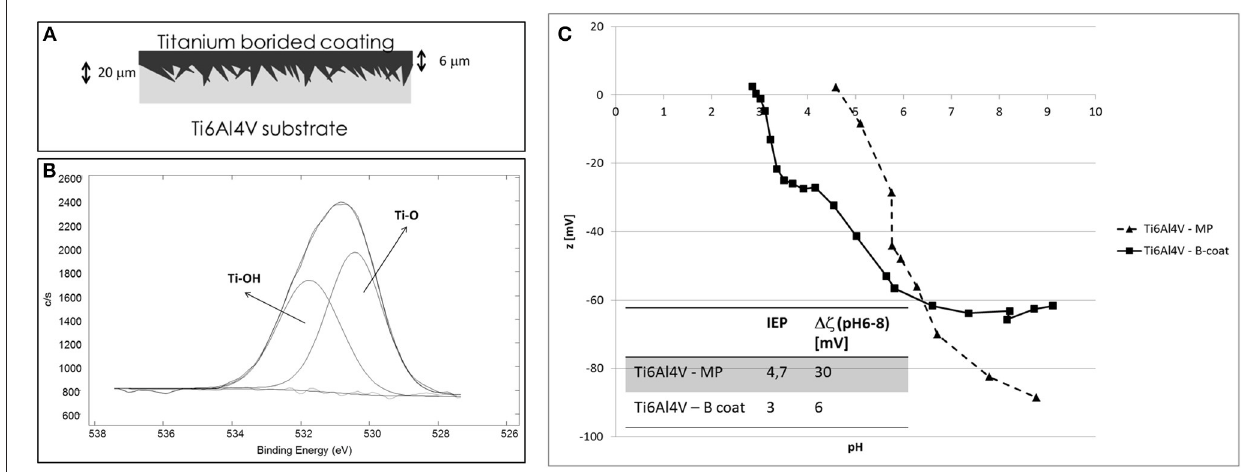
FIGURE 3 | (A) Schematic representation of Ti6Al4V – B-coat surface, (B) XPS high resolution spectrum of the oxygen region for Ti6Al4V – B-coat, and (C) zeta potential vs. pH measurements of Ti6Al4V – MP and Ti6Al4V – B-coat samples.